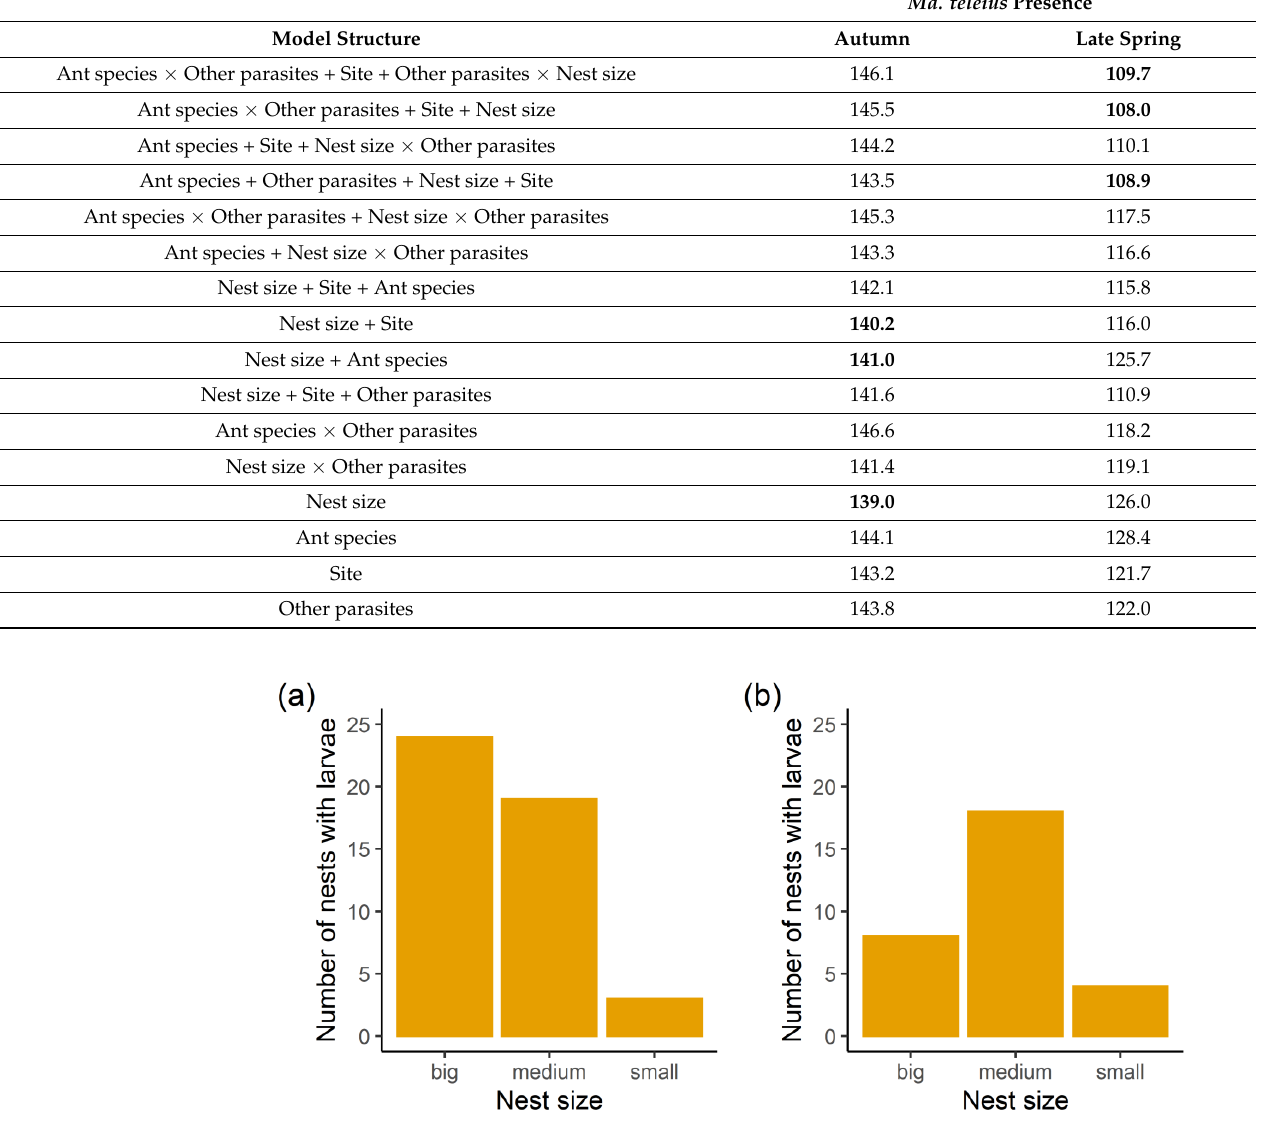
Figure 5. Occurrence of Ma. teleius larvae in nests of different size in ( a ) autumn, and in ( b ) spring. Table 2. AIC values for models with different fixed structures fitted for the two study seasons. The base models relate the presence/absence of Ma. teleius larvae (dependent variable) to all explanatory variables included as fixed effects. Models selected according to information criteria (∆AIC < 2) are in bold.